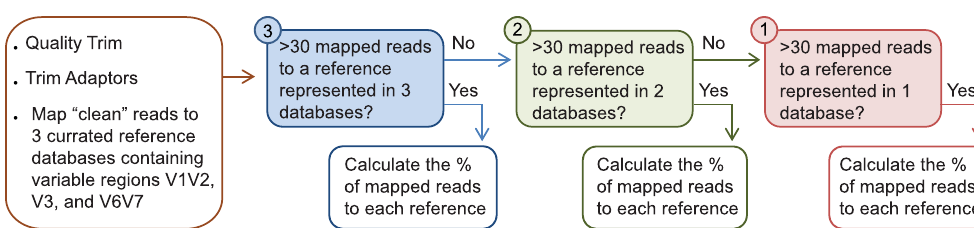
Figure 3. Processing method for taxonomic classification from mapped sequencing reads. Sequencing reads are initially trimmed for quality and adaptors before mapping to three reference databases composed of variable regions V1/V2, V3, and V6/V7. Reference species with greater than 30 reads are grouped into their representative number of databases. The percentage of mapped reads was then calculated and a “best hit” approach was used for final taxonomic